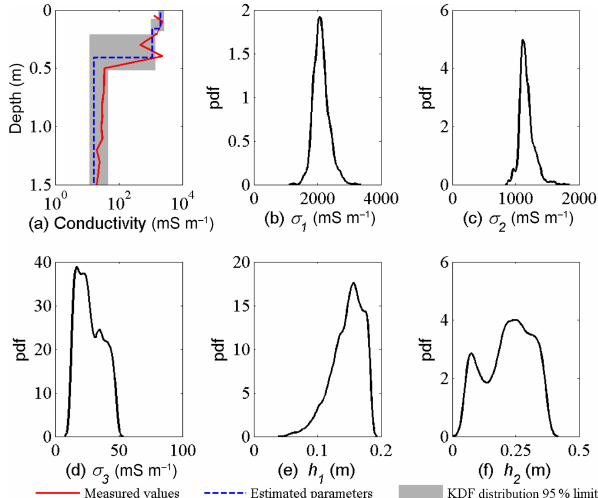
Figure 7. Summary of the MCMC simulation for three-layer earth model by considering CMD Mini-Explorer measurement over a non-saline soil. (a) True (red line) and estimated parameter (blue dashed line) for the vertical electrical conductivity profile, and the gray background with the 95% confidence interval of kernel distri- bution estimation (KDE). (b–f) The KDE of the marginalized pos- terior distributions for the three layer conductivities ( σ 1 , σ 2 , and σ 3 ) and two layer thicknesses ( h 1 and h 2 ).